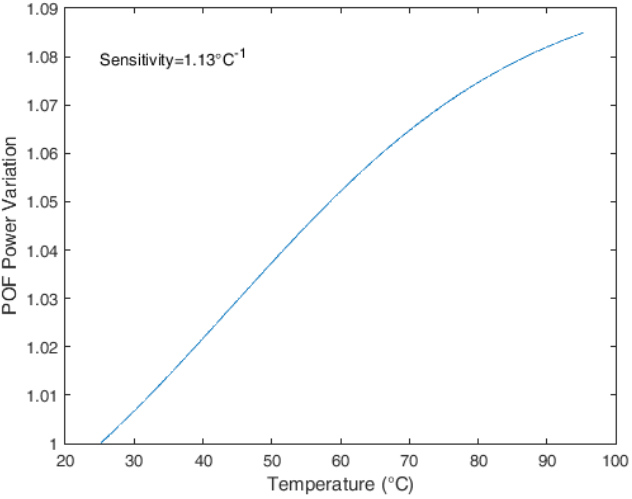
Figure 4. An analytical model of POF power variation under curvature with the temperature increase.